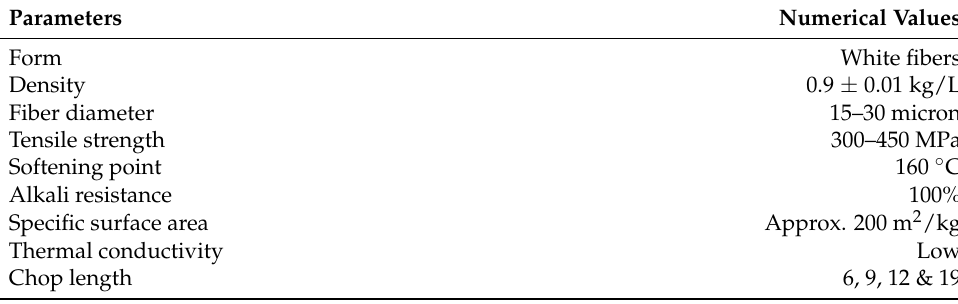
Table 3. Properties of polypropylene fibers.